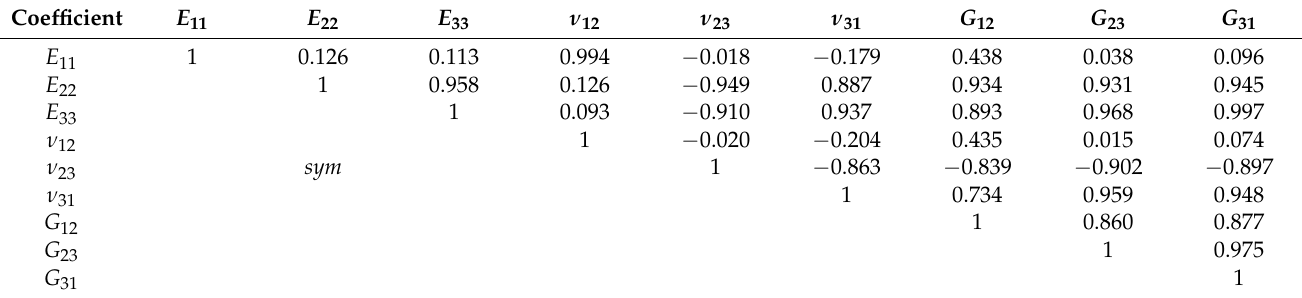
parameter sample data are consistent with the plain weave simulation example. The correlation between special ν 23 and other equivalent parameter samples is negative, and the correlation between E 11 , ν 12 parameter samples is less than 0.018. Table 13. The correlation coefficients between equivalent parameters of 2.5D braided